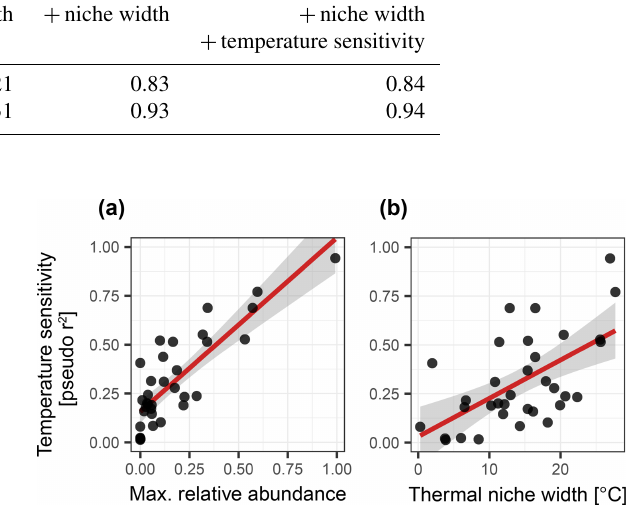
Figure 3. Relationships between temperature sensitivity and (a) maximum relative abundance and (b) thermal niche width of planktonic foraminifera species in the ForCenS dataset. The posi- tive correlation between temperature sensitivity and abundance sug- gests that the thermal niche of abundant species is better defined than that of rare species, rendering abundance a good predictor of species importance. Panel (b) suggests that species with a narrow thermal niche are relatively insensitive to temperature, suggesting that the distribution of these, often rare, species may not be not pri- marily governed by